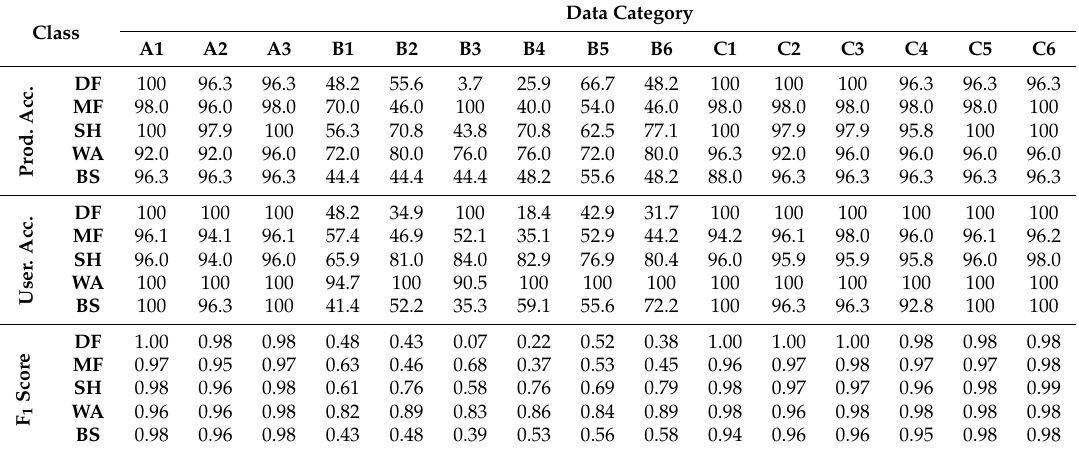
Table 7. Producer’s/user’s accuracy comparison of land cover classification results for different data categories used for various classification scenarios; See Tables 1 and 6 for the description of land cover classes. Prod. Acc. and User. Acc. stands for the producer and user accuracy respectively. Results are based on the validation dataset.